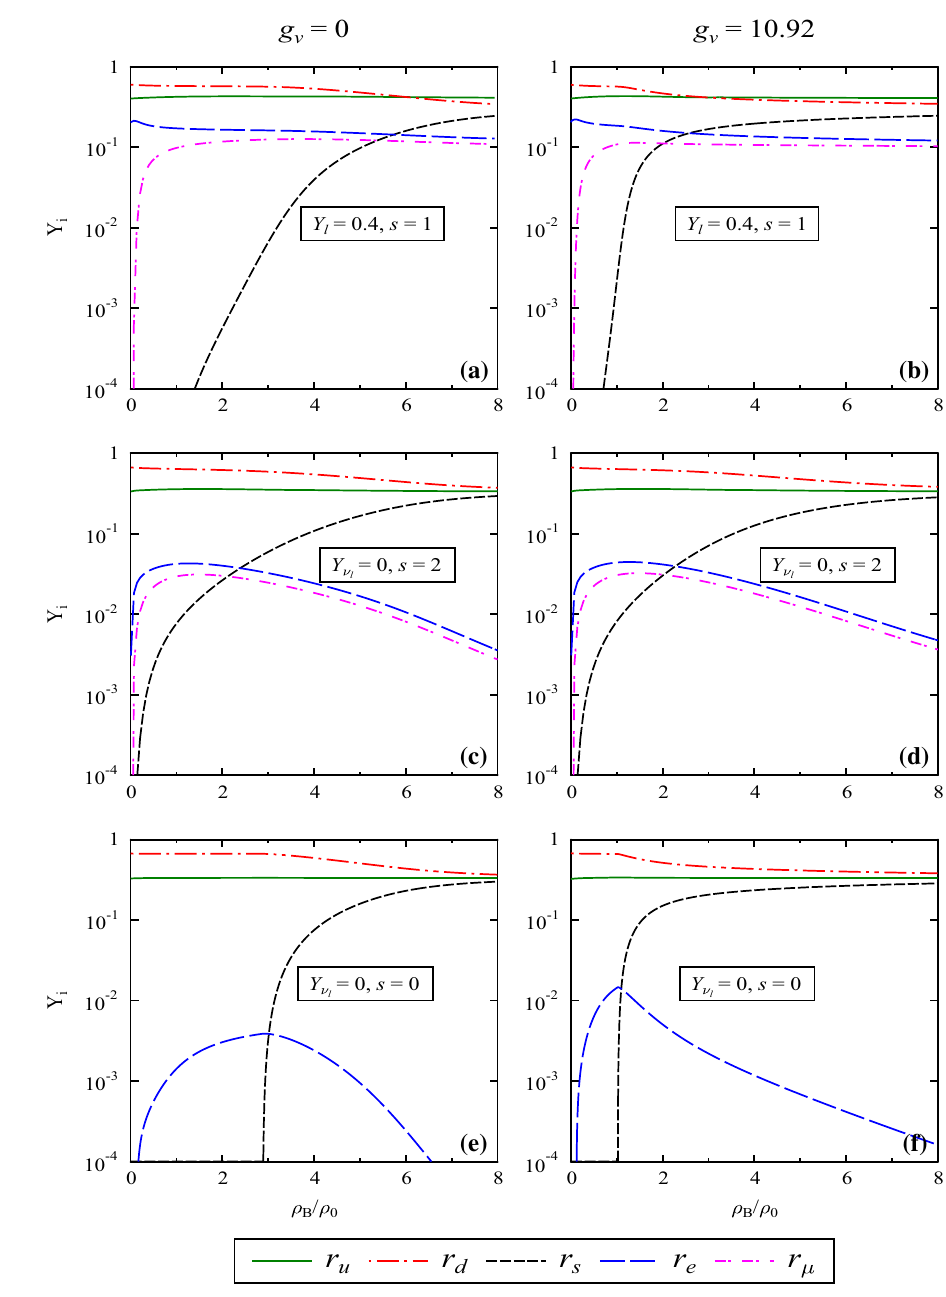
Fig. 1 Particle fractions of quarks ( u , d and s ) and leptons ( e , μ ) at g v = 0 and 10.92 for different snapshots of PQS as a function of baryonic density, ρ B (in units of nuclear saturation density ρ 0